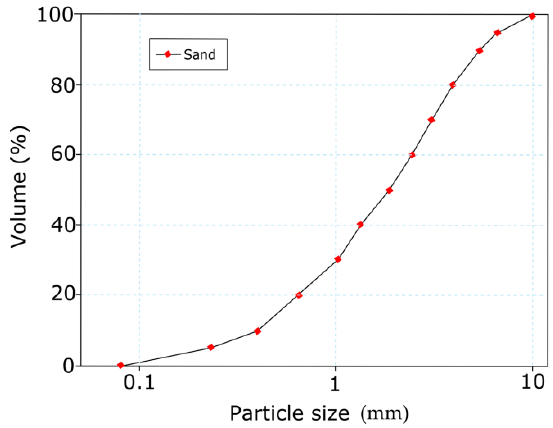
Figure 1. Particle size distribution of sand.